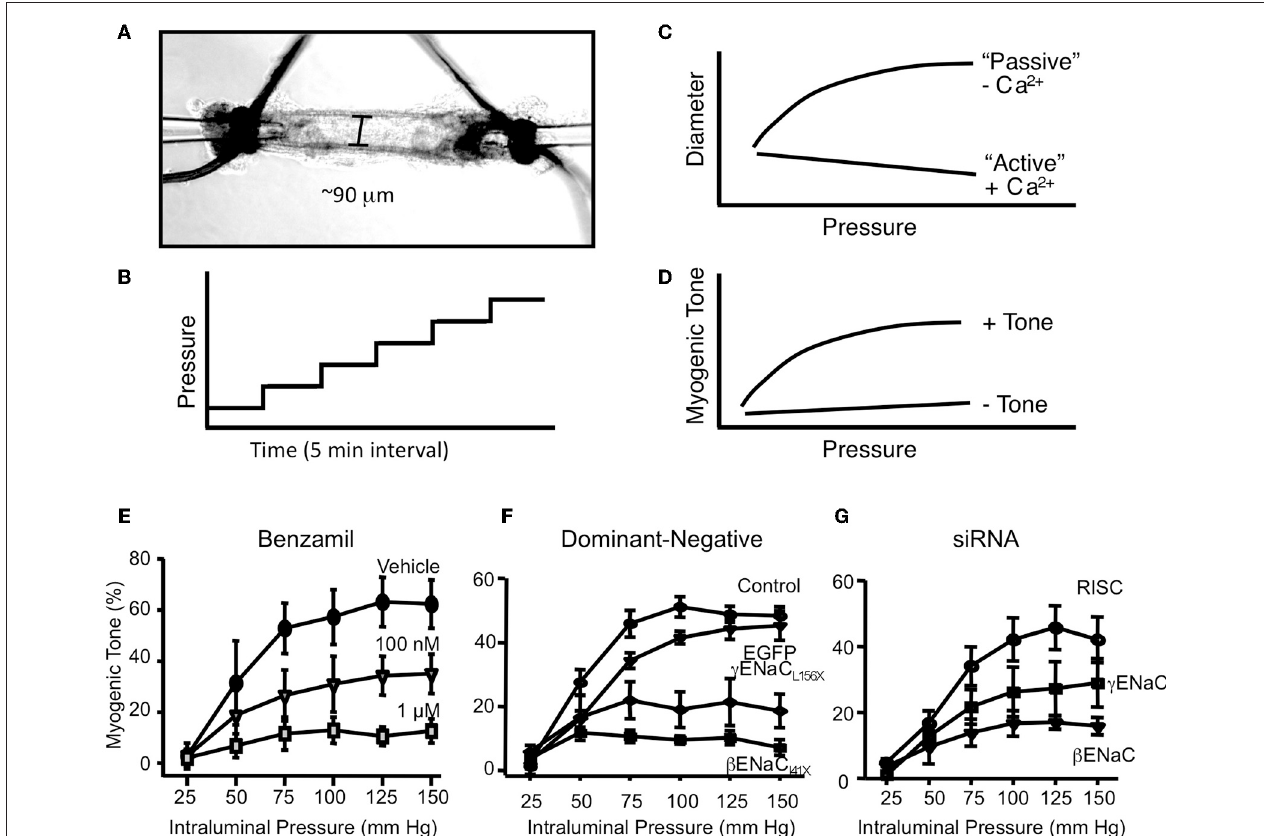
FIGURE 3 | In vitro assessment of myogenic constriction. (A) Image of an isolated renal interlobar artery segment tied to inflow and outflow